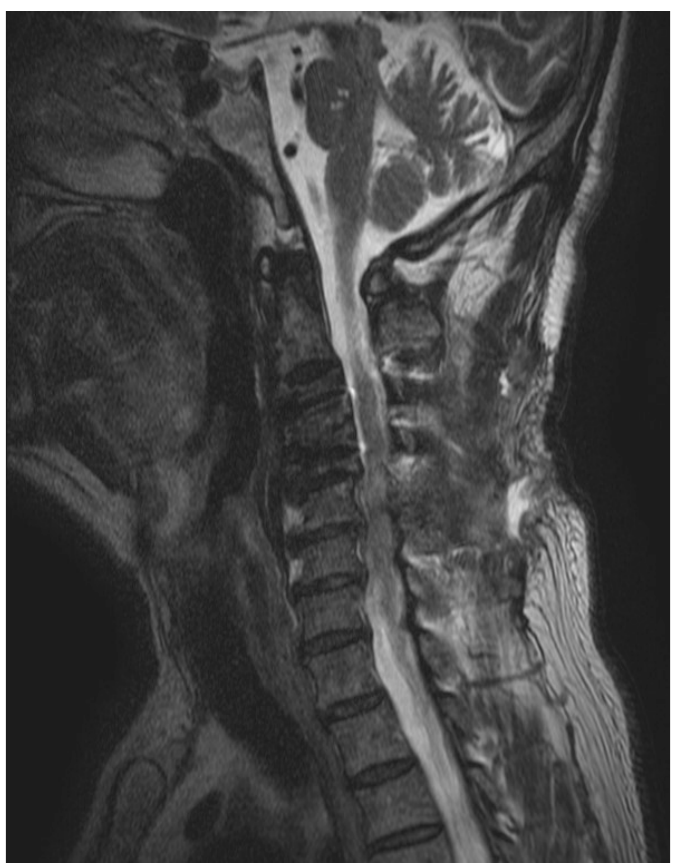
Figure 2. On follow-up magnetic resonance images, there were no previously observed prevertebral